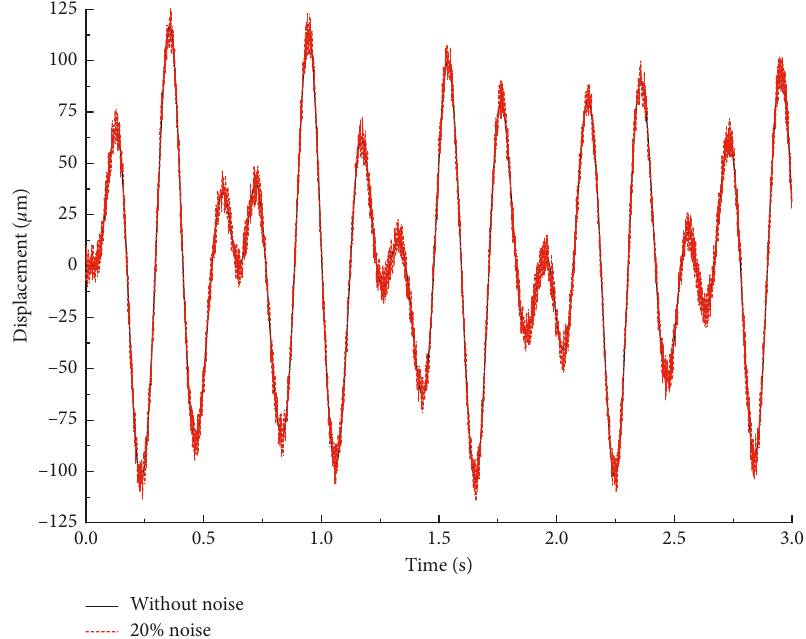
Figure 4: Displacement response of m 2 for the system excited by the harmonic load before and after adding 20%